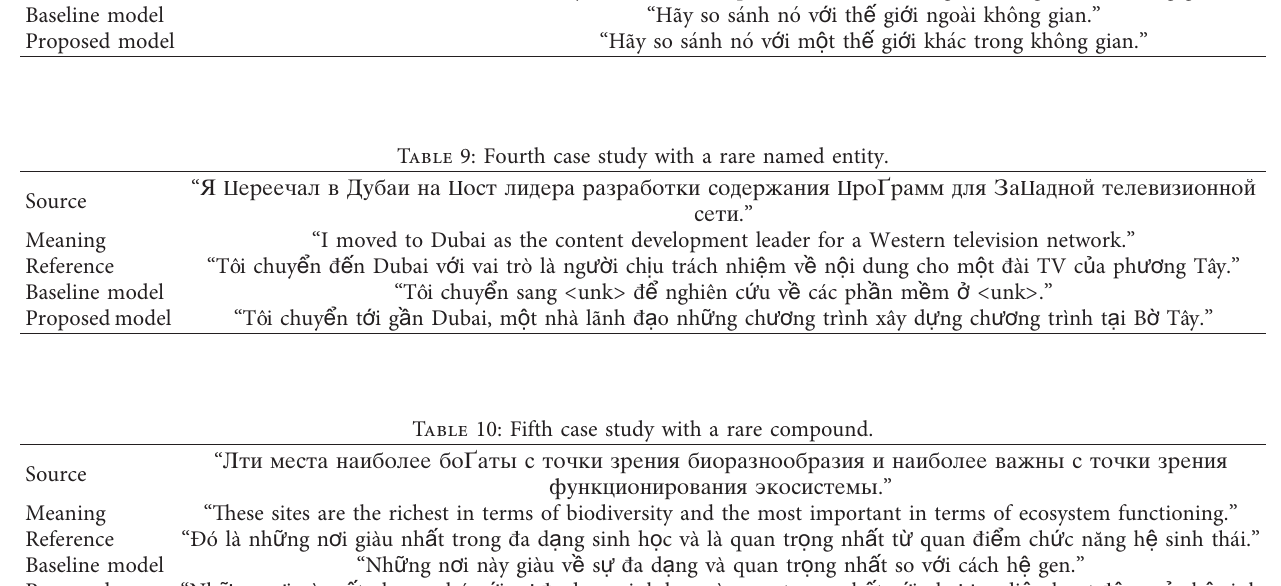
Table 8: Third case study with incorrect translations. “And let’s compare it with the rest of the world in a spatial